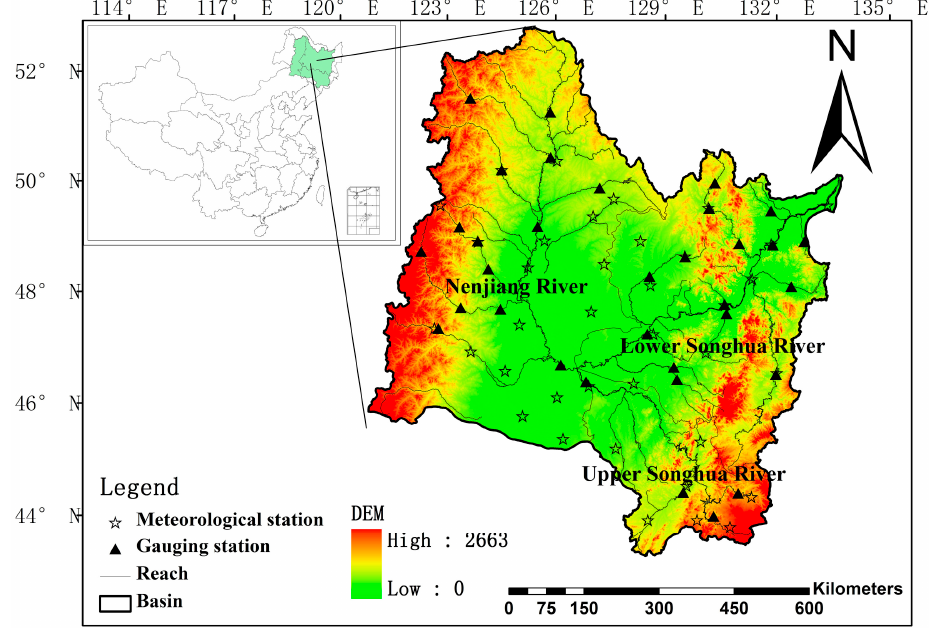
Figure 1. The Songhua River Basin in northeastern China and the gauging (triangles) and meteorological (stars) stations used in this study.